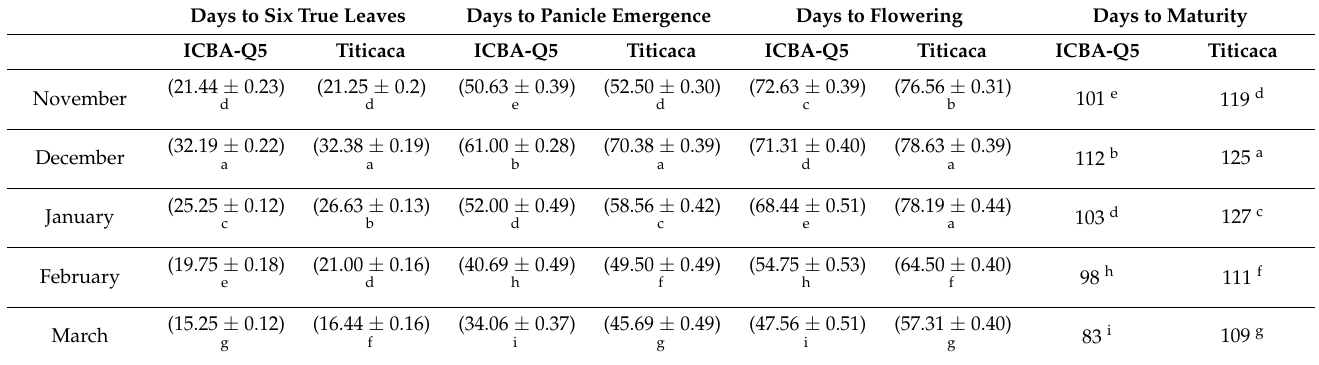
Table 2. Days from sowing to six true leaves, panicle emergence, flowering and maturity as affected by sowing dates and quinoa cultivars (mean ± SD, n